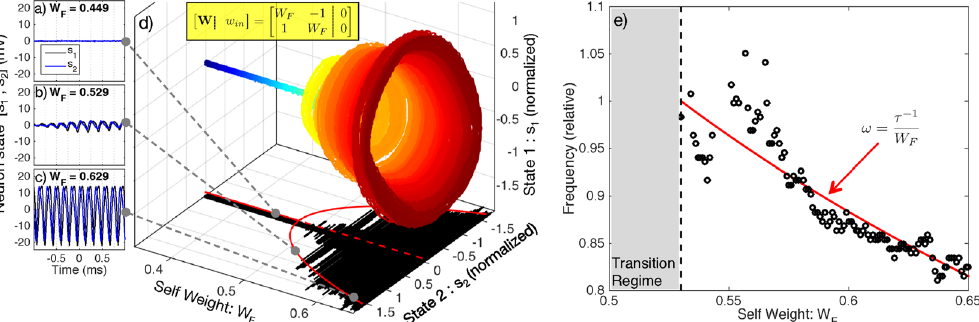
Figure 3. A Hopf bifurcation between stable and oscillating states. ( a – c ) Time traces below, near, and above the bifurcation. ( d ) Oscillation growth versus feedback weight strength. Color corresponds to feedback weight parameter, W F , to improve visibility. Black shadow: average experimental amplitudes; solid red curve: corresponding fit model; dotted red line: unstable branch. ( e ) Frequency of oscillation above the Hopf bifurcation. The observed data (black points) are compared to the expected trend of equation (S1.10) (red curve). Frequencies are normalized to the threshold frequency of 4.81 kHz.